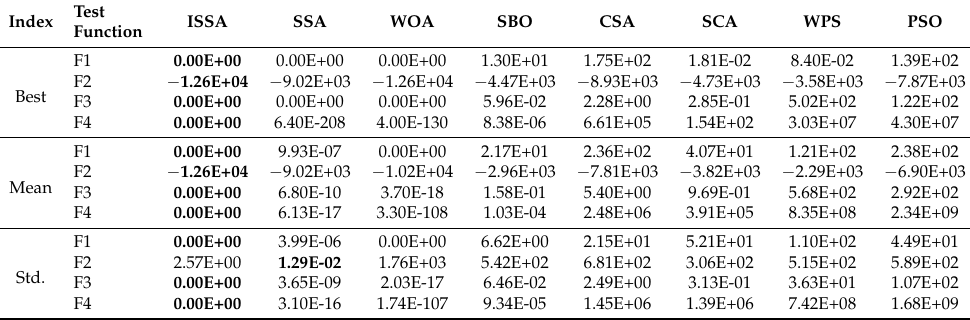
Table 7. Benchmark function test optimization